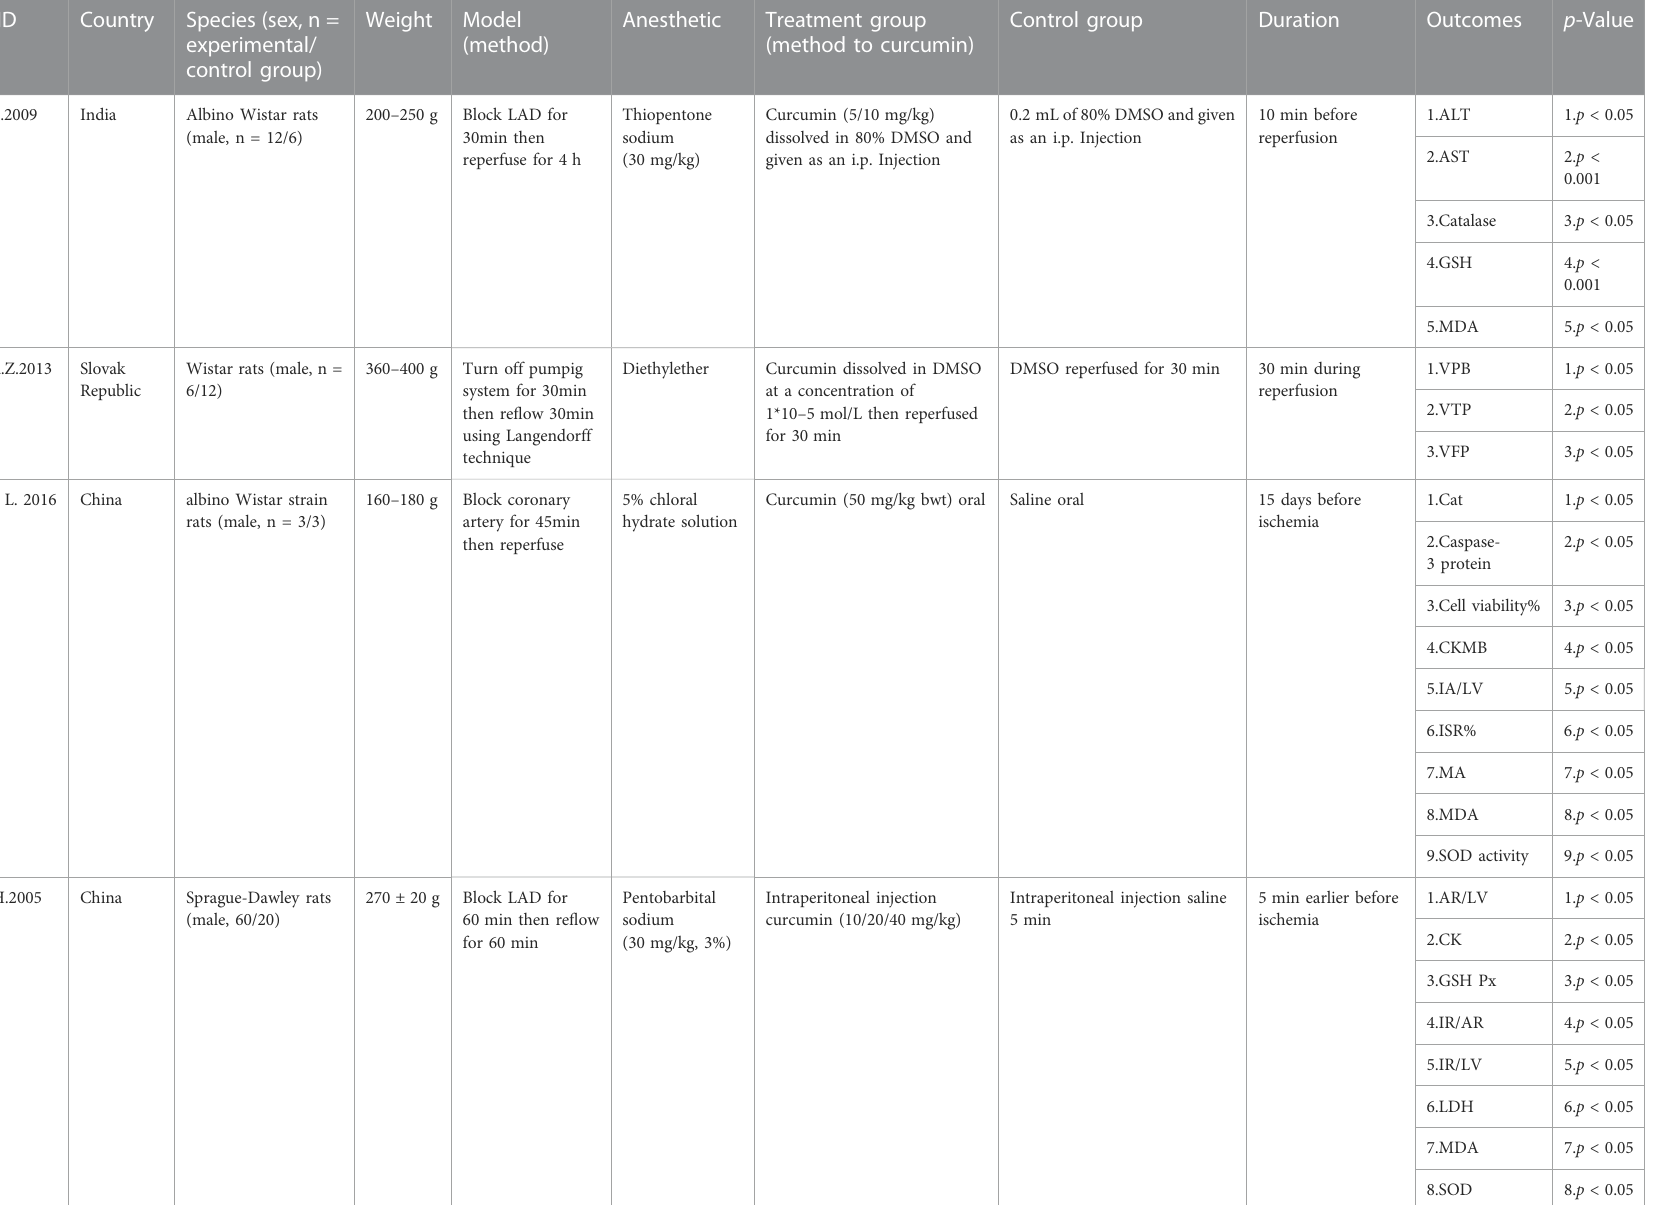
TABLE 1 Basic characteristics of the 24 included animal